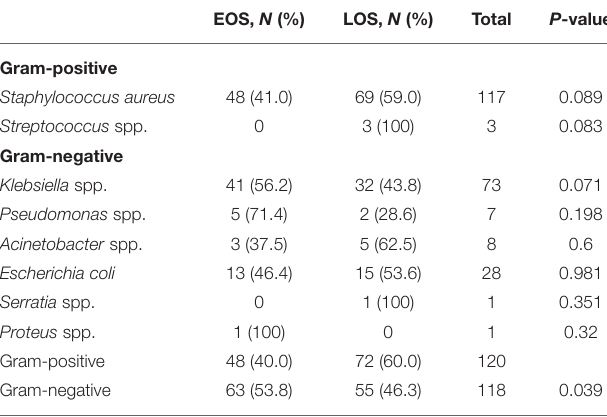
TABLE 4 | Distribution of microorganisms according to time of